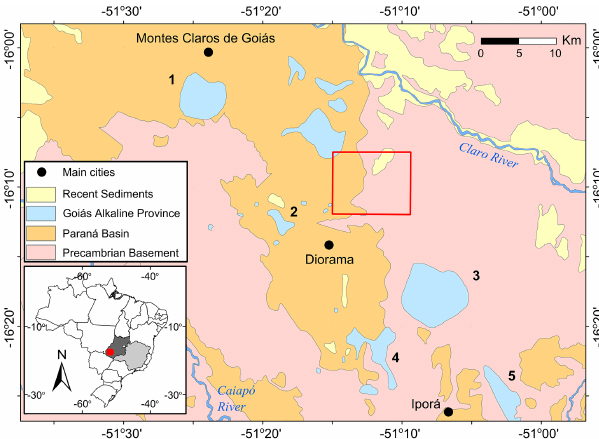
Figure 14. Application to field data on the Goiás alkaline province (GAP), Brazil. Simplified geological map of the study area, which is shown as a red dot on the inset map of Brazil. The inset also shows the Goiás (dark grey area) and Minas Gerais (light grey area) states. The total-field anomaly over the area delimited by the red rectangle is shown in Fig. 15. The coordinates are referred to as the WGS84 datum. The numbers indicate the main alkaline complexes in this region: 1 – Montes Claros de Goiás; 2 – Diorama; 3 – Córrego dos Bois; 4 – Morro do Macaco; and 5 – Fazenda Buriti.